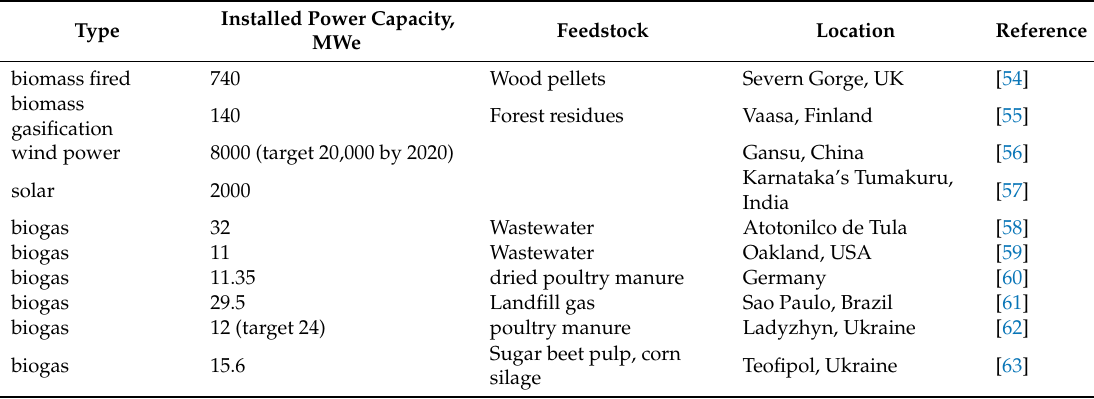
Table 1. Largest renewable energy power